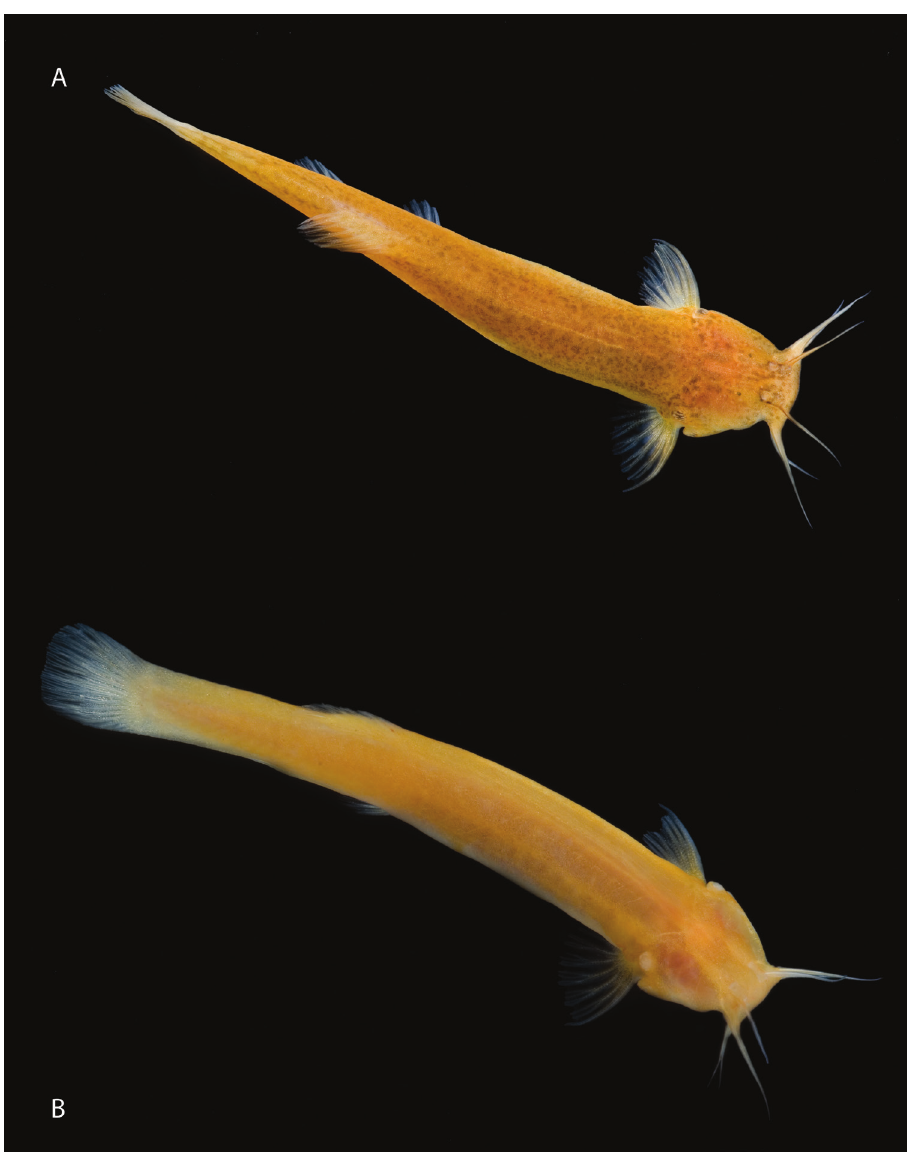
Figure 1. Trichomycterus itacarambiensis (Siluriformes: Trichomycteridae), troglobitic catfish from east- ern Brazil, showing intrapopulation variation in pigmentation and eye development (Photos: Dante Feno- lio). A pigmented individual, with reduced eyes and pigmentation B albino (DOPA (–) individual, with very reduced eyes, not visible